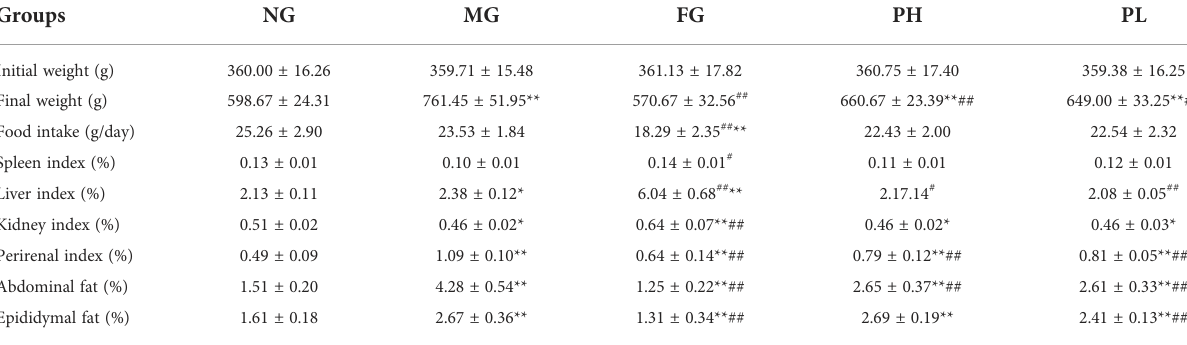
TABLE 3 Effects of puerarin on body weight, food intake, and organ and fat coef fi cient.